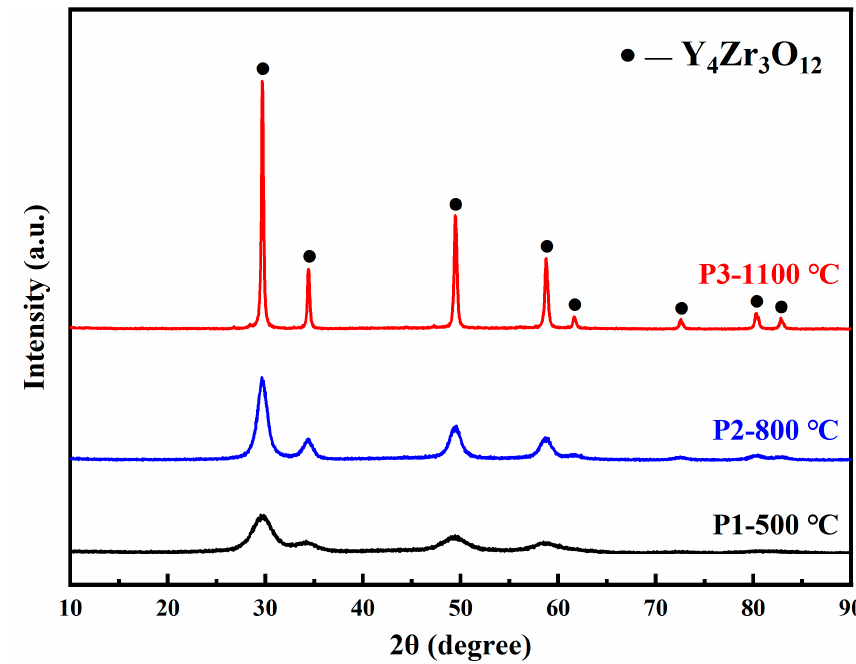
Figure 4. XRD patterns of the Y 4 Zr 3 O 12 powders calcined at different temperatures.